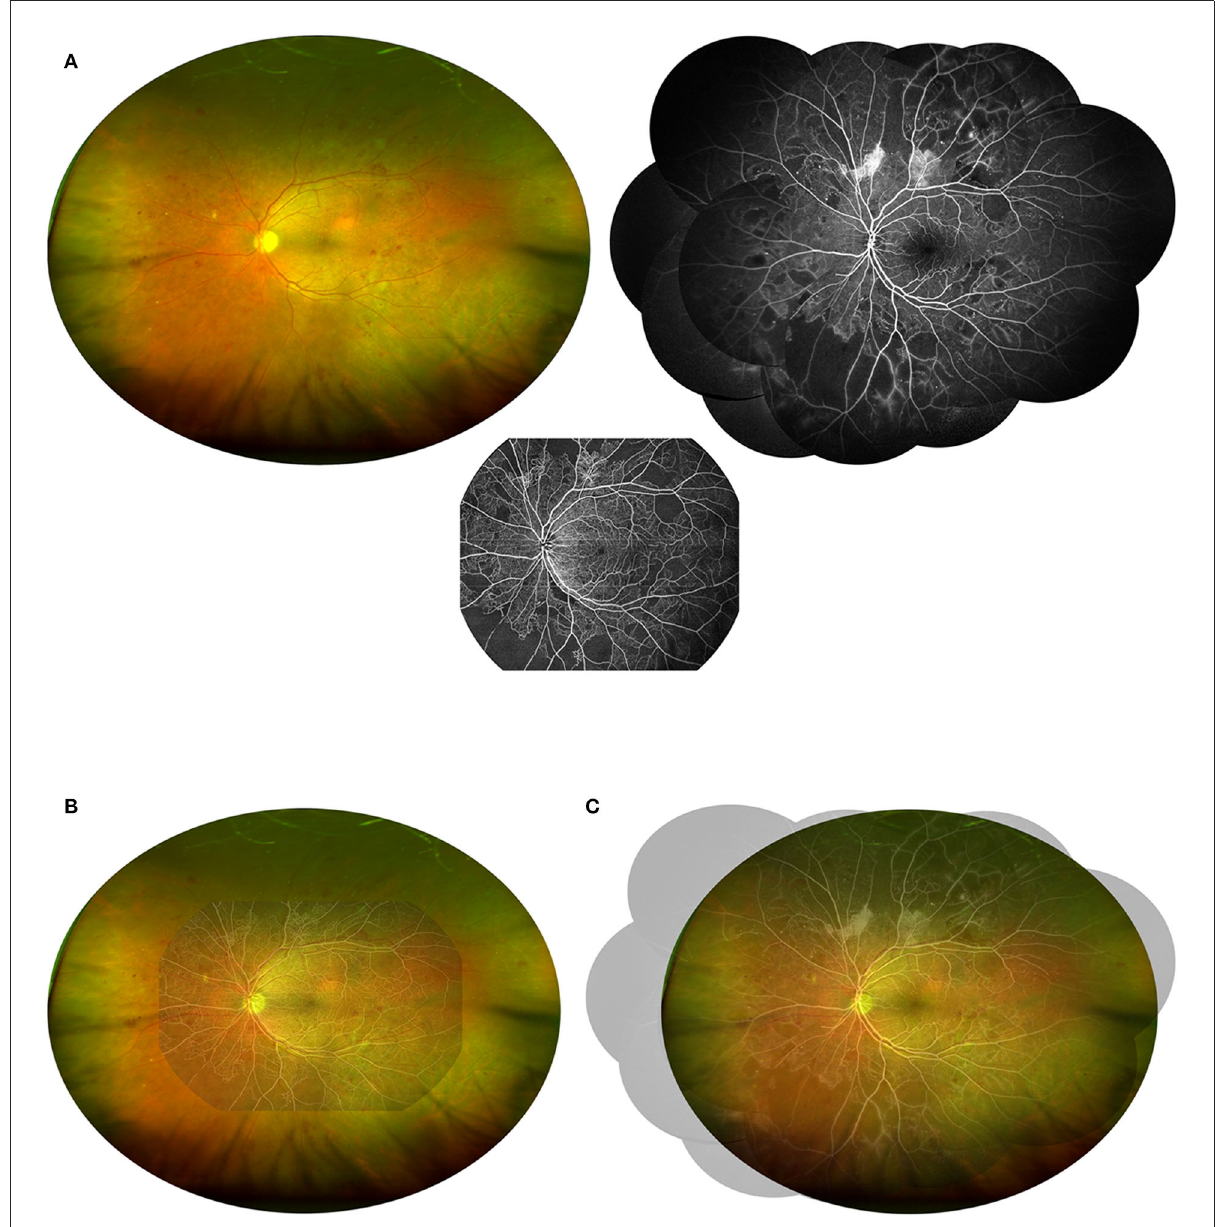
FIGURE2 Demonstration of the combination of UWF CFP with UWF SS-OCTA or FFA. (A) The UWF CFP, UWF SS-OCTA, and FFA (montaged) images of the same patients shown in Figure 1 were adjusted to a 1:1 ratio and merged in pairs to visually demonstrate the field of view of the two combinations including UWF CFP plus UWF SS-OCTA (B) and UWF CFP plus FFA (C)